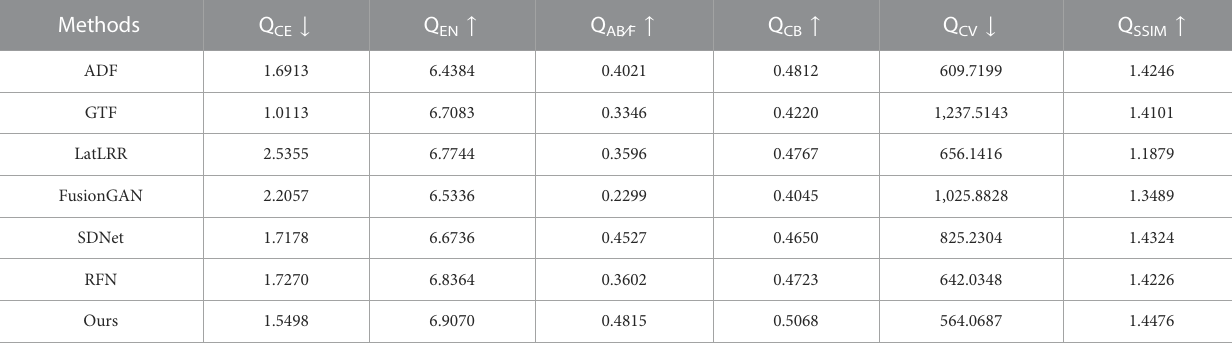
TABLE 1 Quantitative evaluation of different fusion methods on 39 pairs of images from TNO and VOT2020-RGBT datasets. The red font indicates the optimal results and the blue font indicates the sub-optimal results.